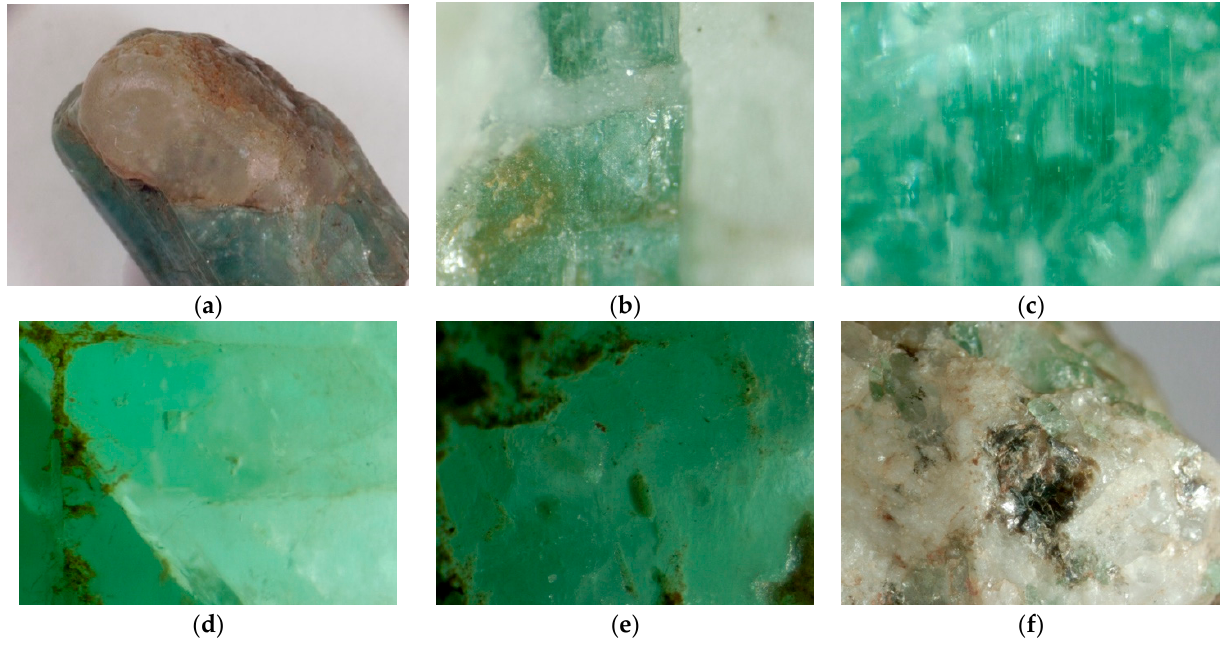
Figure 5. Macroscopic and microscopic characteristics of emeralds from Egypt. ( a ) Quartz crystal which interrupts the growth of an emerald crystal (ENSMP 72466_03); FOV: 8 mm, ( b ) Quartz vein which interrupts the growth of an emerald crystal (ENSMP 47849a26); FOV: 2 mm, ( c ) Growth tubes and rectangular shaped multiphase inclusions parallel to the c-axis (ENSMP 13512_5); FOV: 1 mm, ( d ) Rectangular crystal inclusion in an emerald crystal (ENSMP 72466_02); FOV: 1 mm, ( e ) Macroprismatic crystal inclusion of mica in an emerald crystal (ENSMP 72466_04); FOV: 1 mm, ( f ) Mica, quartz and plagioclase in the host rock of Egyptian emeralds (ENSMP 47849a27); FOV: 4 mm. Microphotos by Ugo Hennebois/LFG; © Musée de Minéralogie Mines Paris—PSL.